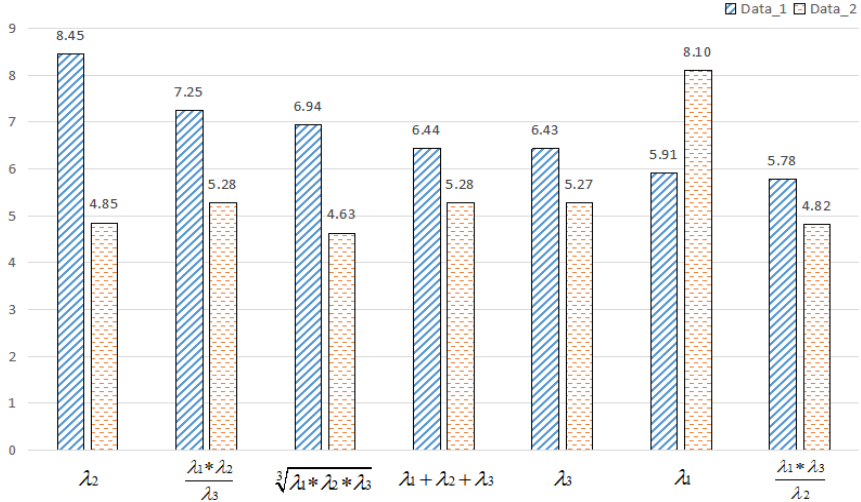
Figure 3. Weight corresponding to each feature .